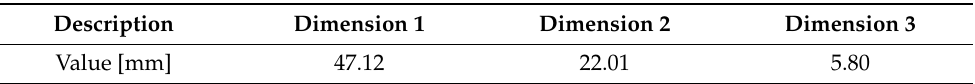
Table 25. Measurement results of dimension 1, 2, and 3 of the open lever with shrinkage-rate constant applied and additional correction of the dimension